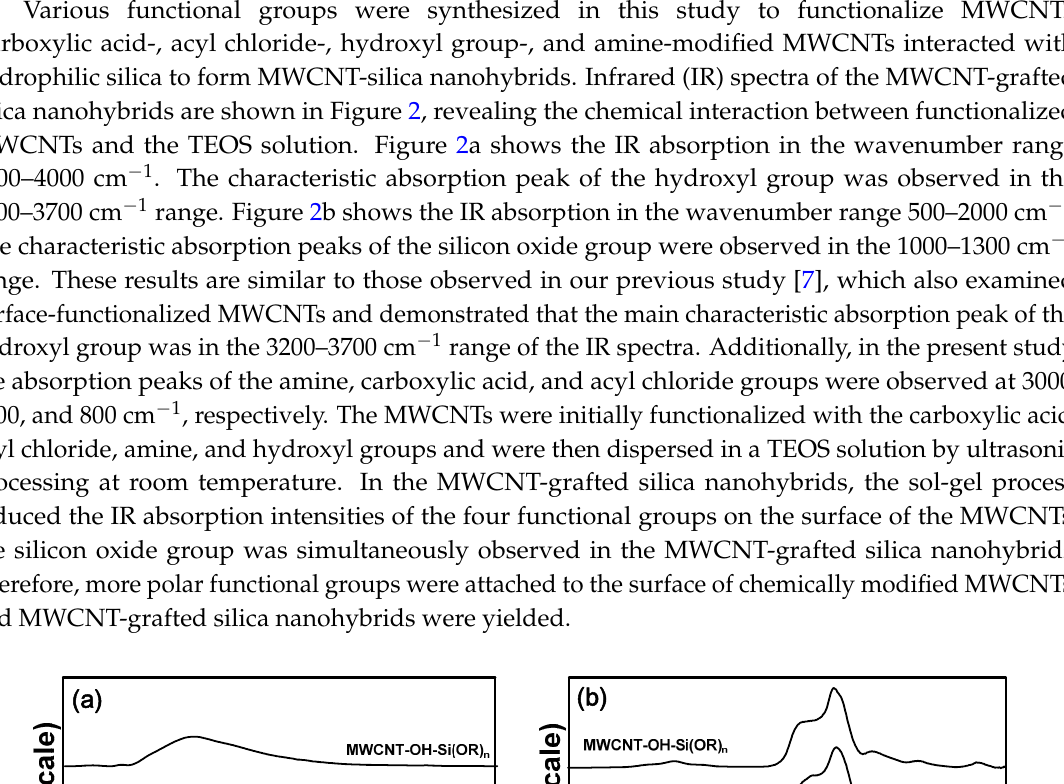
Figure 3. The solid-state 29 Si NMR spectra of silica and MWCNT-grafted silica nanohybrids: ( a ) neat silica; ( b ) MWCNT-COOH-silica; ( c ) MWCNT-COCl-silica; ( d ) MWCNT-NH 2 -silica; and ( e ) MWCNT-OH-silica. TEOS is the ideal chemical precursor in sol-gel synthesis because it reacts readily with water. The mechanism of the sol-gel process is as follows [20,26,32–35]. Hydrolysis: